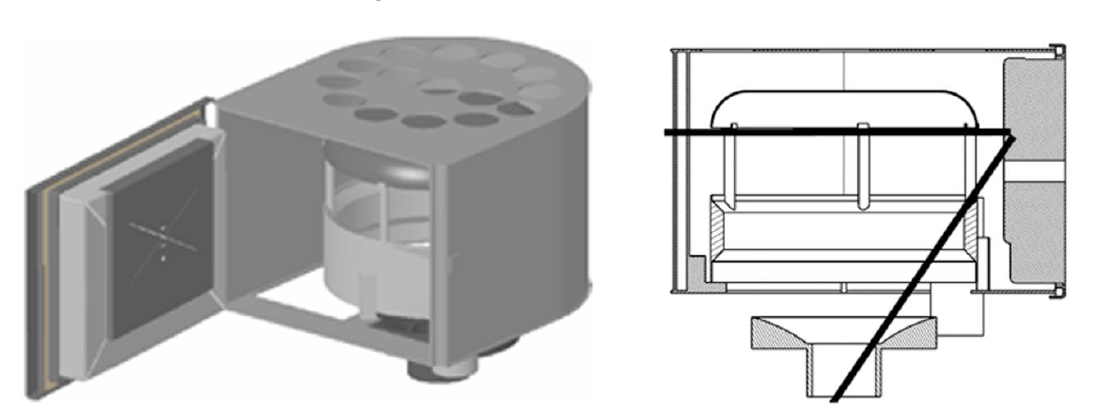
Figure 2. Instrumentation